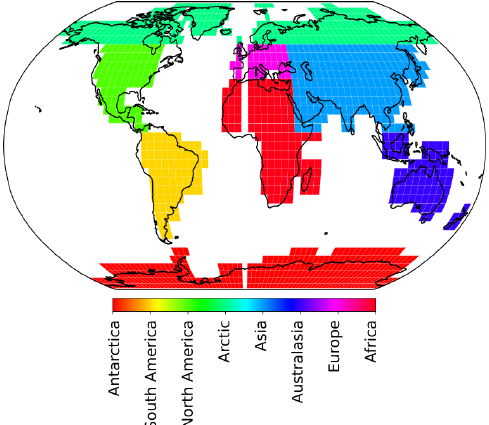
Figure A2. Inter-continental temperature correlations for all ensemble members. Panel (a) is the default simulation. Also indicated per experiment is the magnitude of AMOC variability (standard deviation in Sv) using the size of the red dot in the upper-right corner. These values are lagged correlations. See Fig. A3 for the results of the non-lagged correlations.